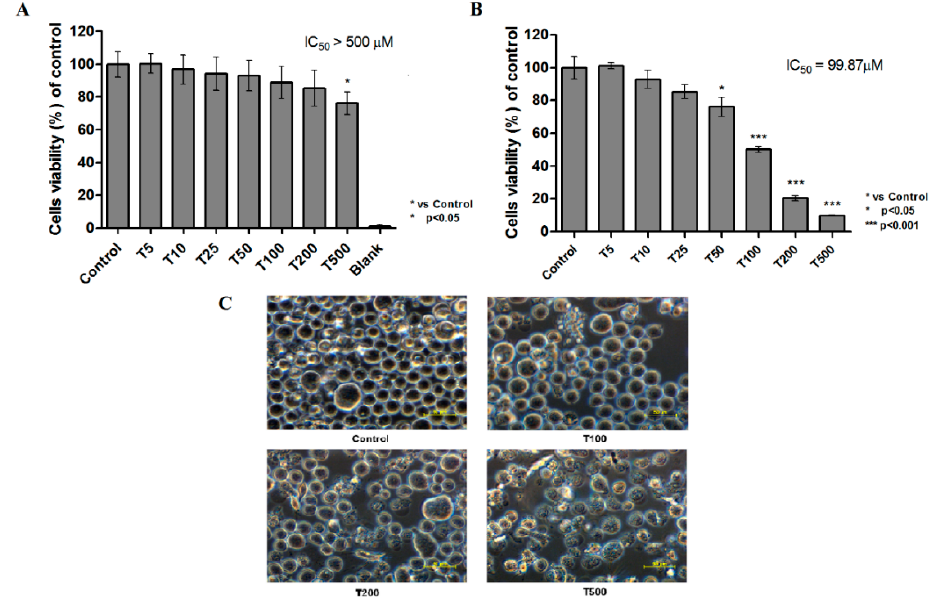
Figure 3. Relative viability of ( A ) skin fibroblast cell line—BJ; and ( B ) RPMI 8226 cell line treated with teriflunomide (T) (5–500 µM) or DMSO as vehicle in control cultures for 24 h determined by MTT assay. ‘Blank’ presents results for mixture of medium without cells, MTT and DMSO. The results were calculated as % of control cultures viability which were averaged to define the 100%. Values were presented as mean ± SD derived from three independent experiments. ( C ) RPMI 8226 cells morphology analyzed under a phase-contrast microscope Nikon Eclipse Ti. The cells were treated with teriflunomide (T) (100–500 µM) or DMSO as vehicle in control cultures for 24 h (magnification ×600, scale bar = 50 µm).